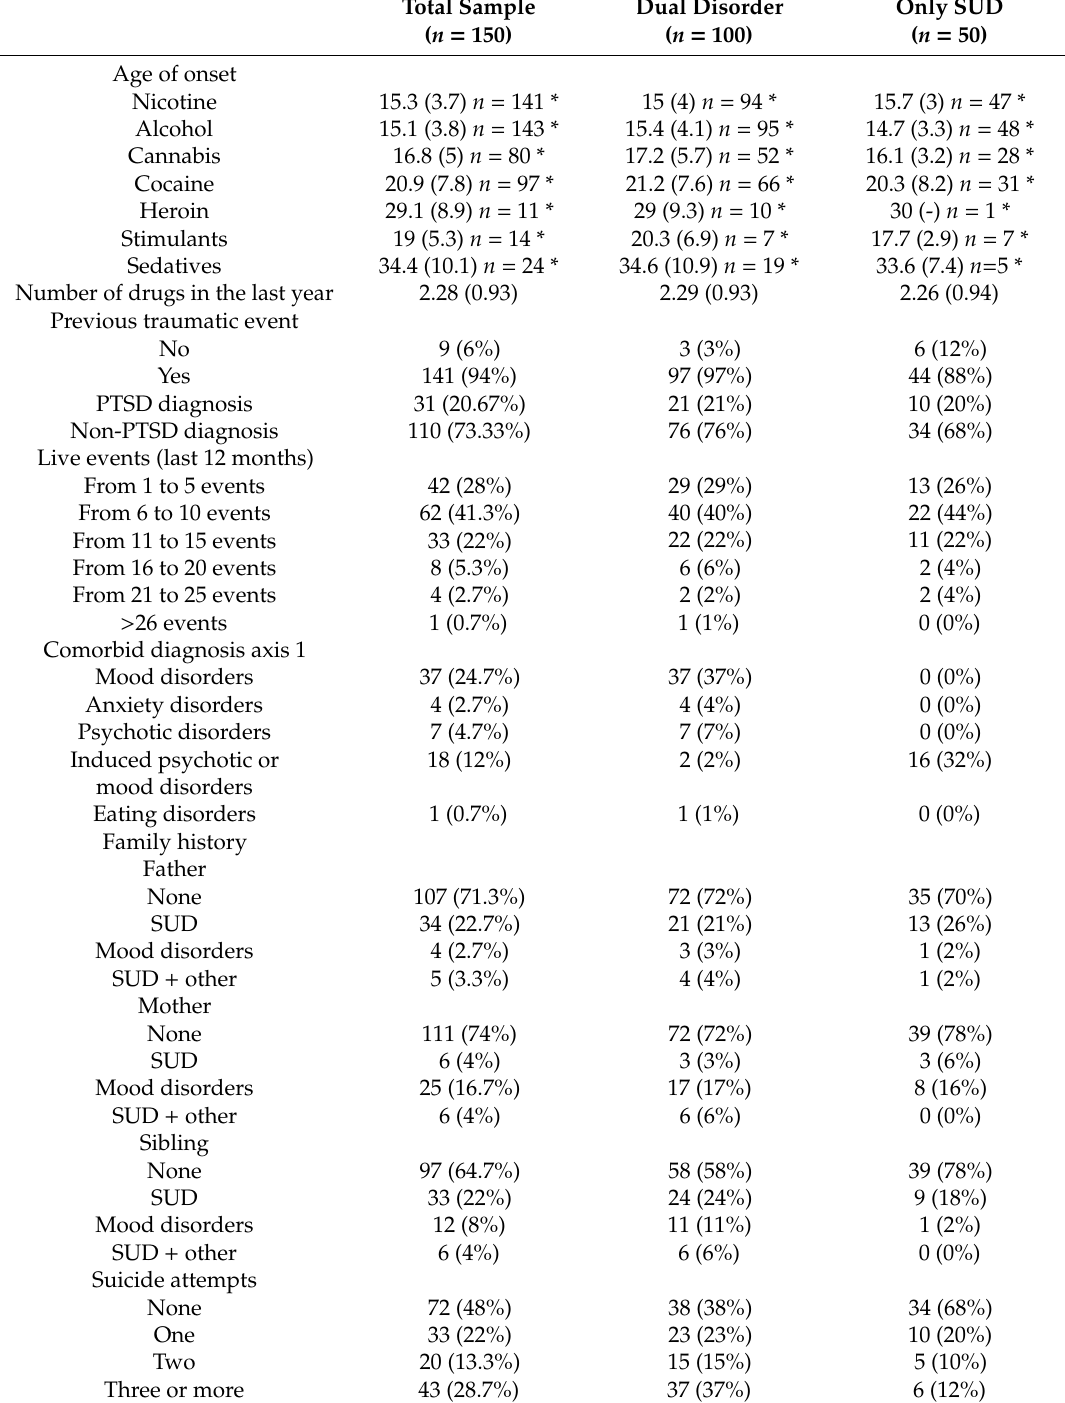
Table 2. Clinical characteristics of the sample. Data are presented as mean (SD) and / or number (%). Total